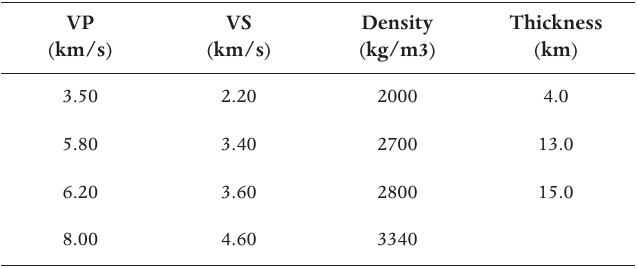
Table 2. The crustal velocity structure used in the present study (modified from Horasan et al.